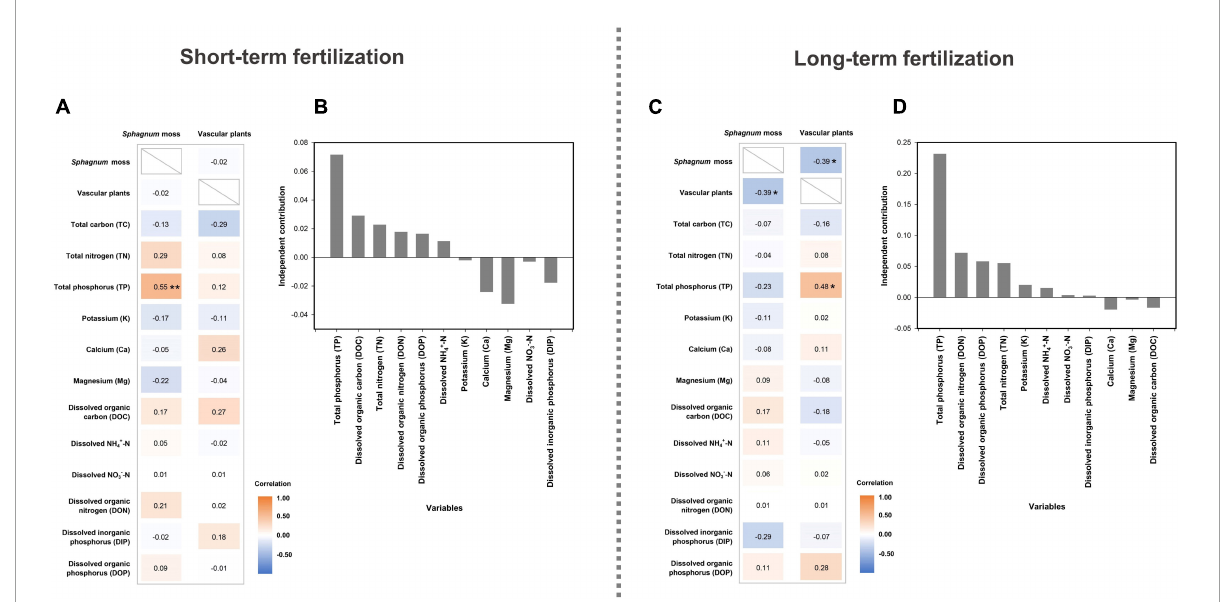
FIGURE2 Spearman’s correlations between plant species abundance and physicochemical properties of peat and porewater under the short- (A) and long-term fertilizations (C) , and the hierarchical partitioning between physicochemical properties of peat and porewater and the humification indices under the short- (B) and long-term fertilizations (D) . Asterisks represent significant correlations.